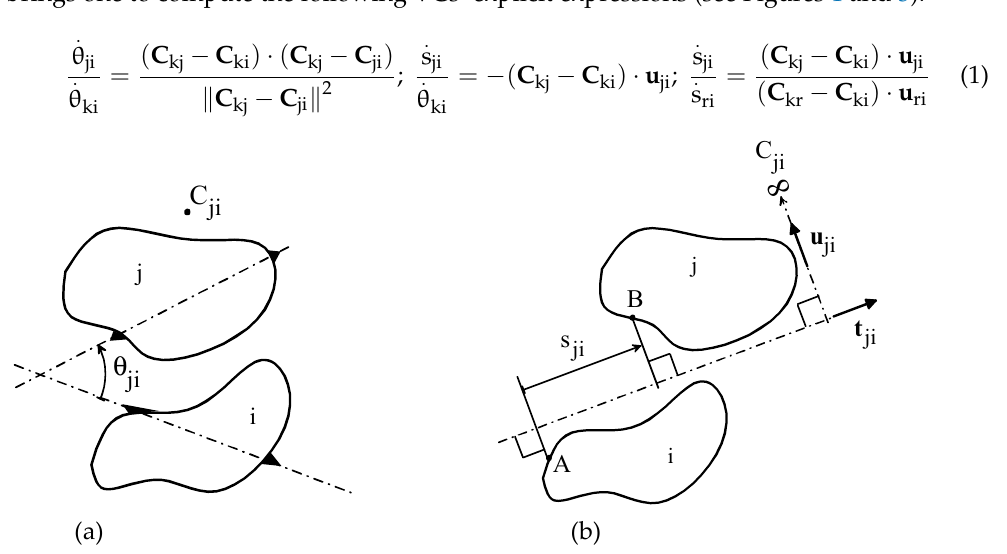
Figure 3. Relative (planar) motion between any two links, denoted j and i: ( a ) instantaneous rotation (the IC C ji is a finite point), ( b ) instantaneous translation along the direction of the unit vector t ji (the IC C ji is the point at infinity the unit vector u ji points to).